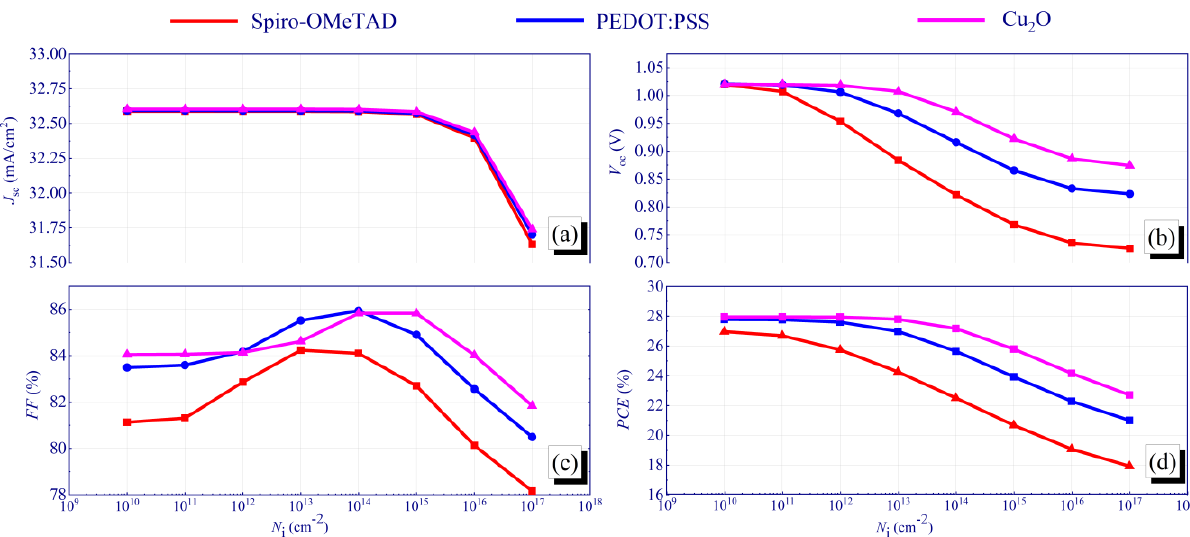
Figure 6. Influence of the concentration of interfacial defects ( N i ) at the CH 3 NH 3 SnI 3 /HTL (IL2) interface: ( a ) J SC , ( b ) V OC , ( c ) FF , ( d ) PCE